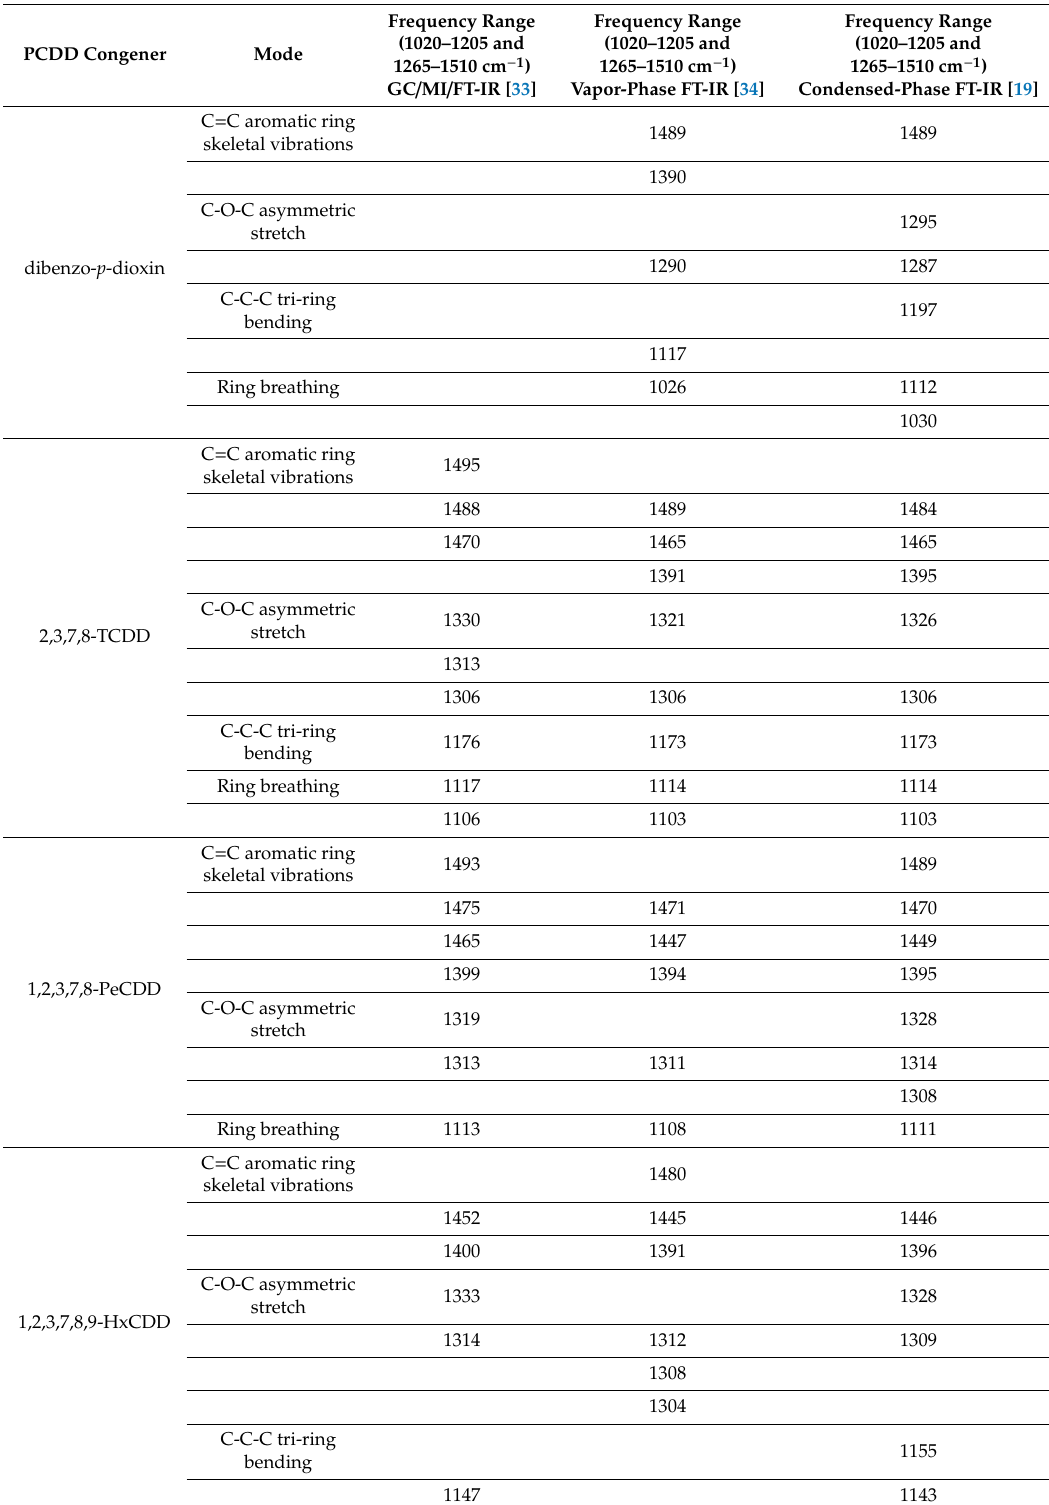
Table 1. Principal FT-IR bands of PCDDs. Reprinted with permission from [19], copyright 2014.